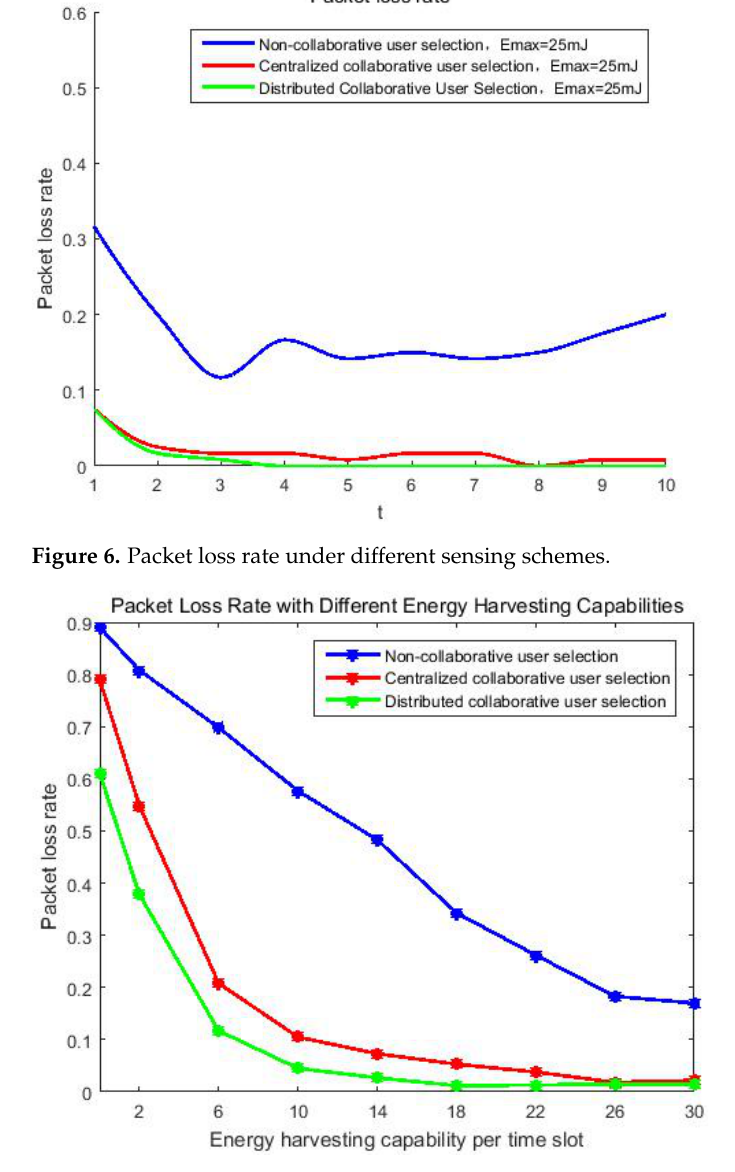
Figure 7. Packet loss rate under different energy harvesting capabilities.